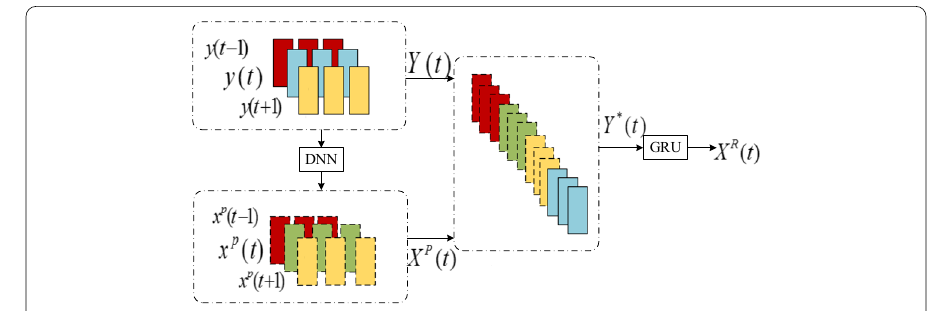
Fig. 6 Feature data